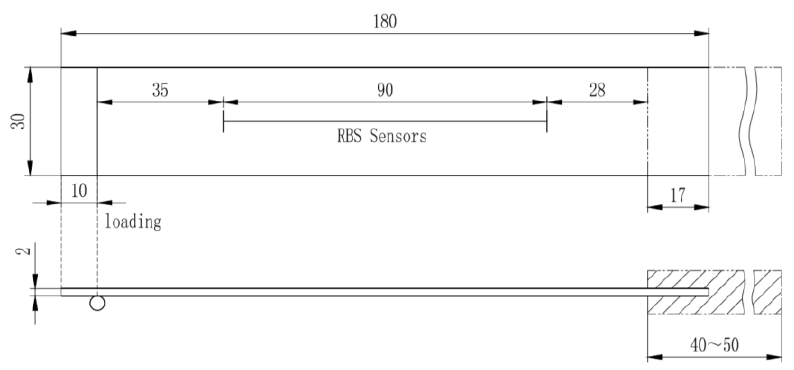
Figure 19. Specimen geometry and test setup.